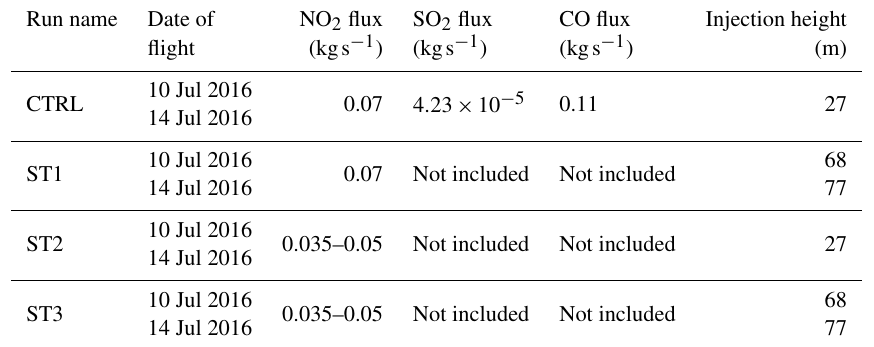
Table 1. Flux and injection height for the reference control run (CTRL) and for the sensitivity tests (STs) for each day of